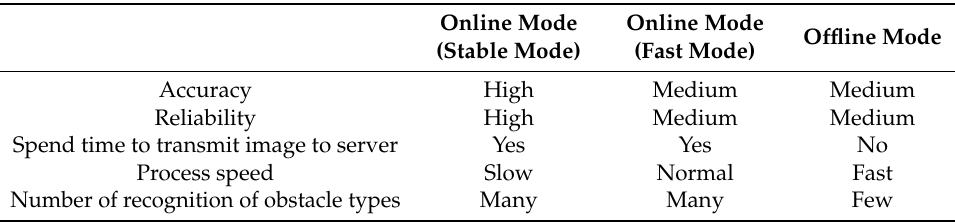
Table 2. Comparison of different modes.